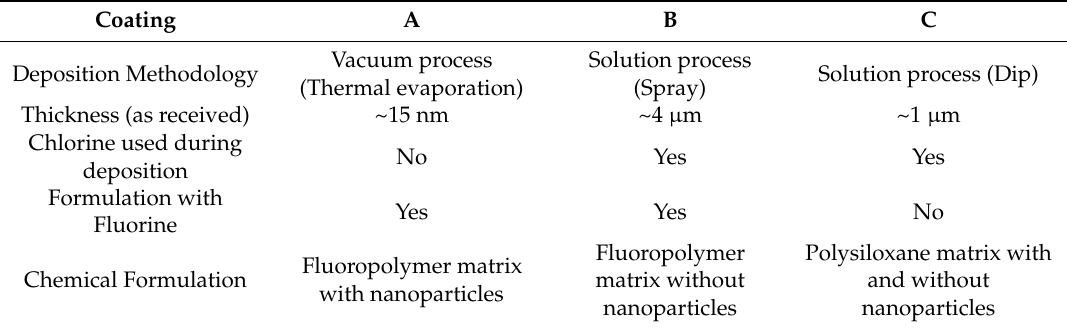
Table 1. A summary of the types of hydrophobic coatings